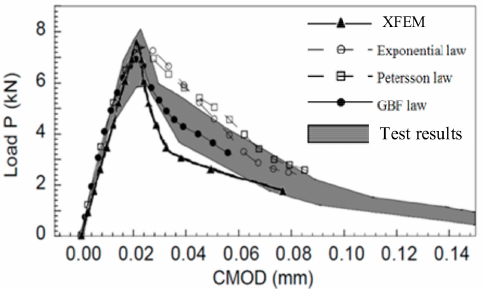
Figure 11. Comparison of the load–crack mouth opening displacement (P-CMOD)